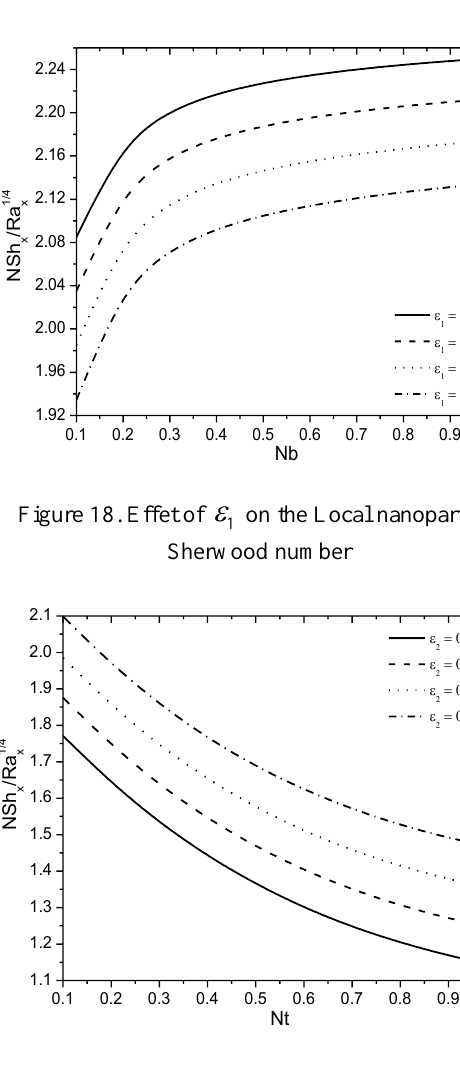
 on the Local Nusselt number Figure 20. Effet of Figure 19. Effet of 2